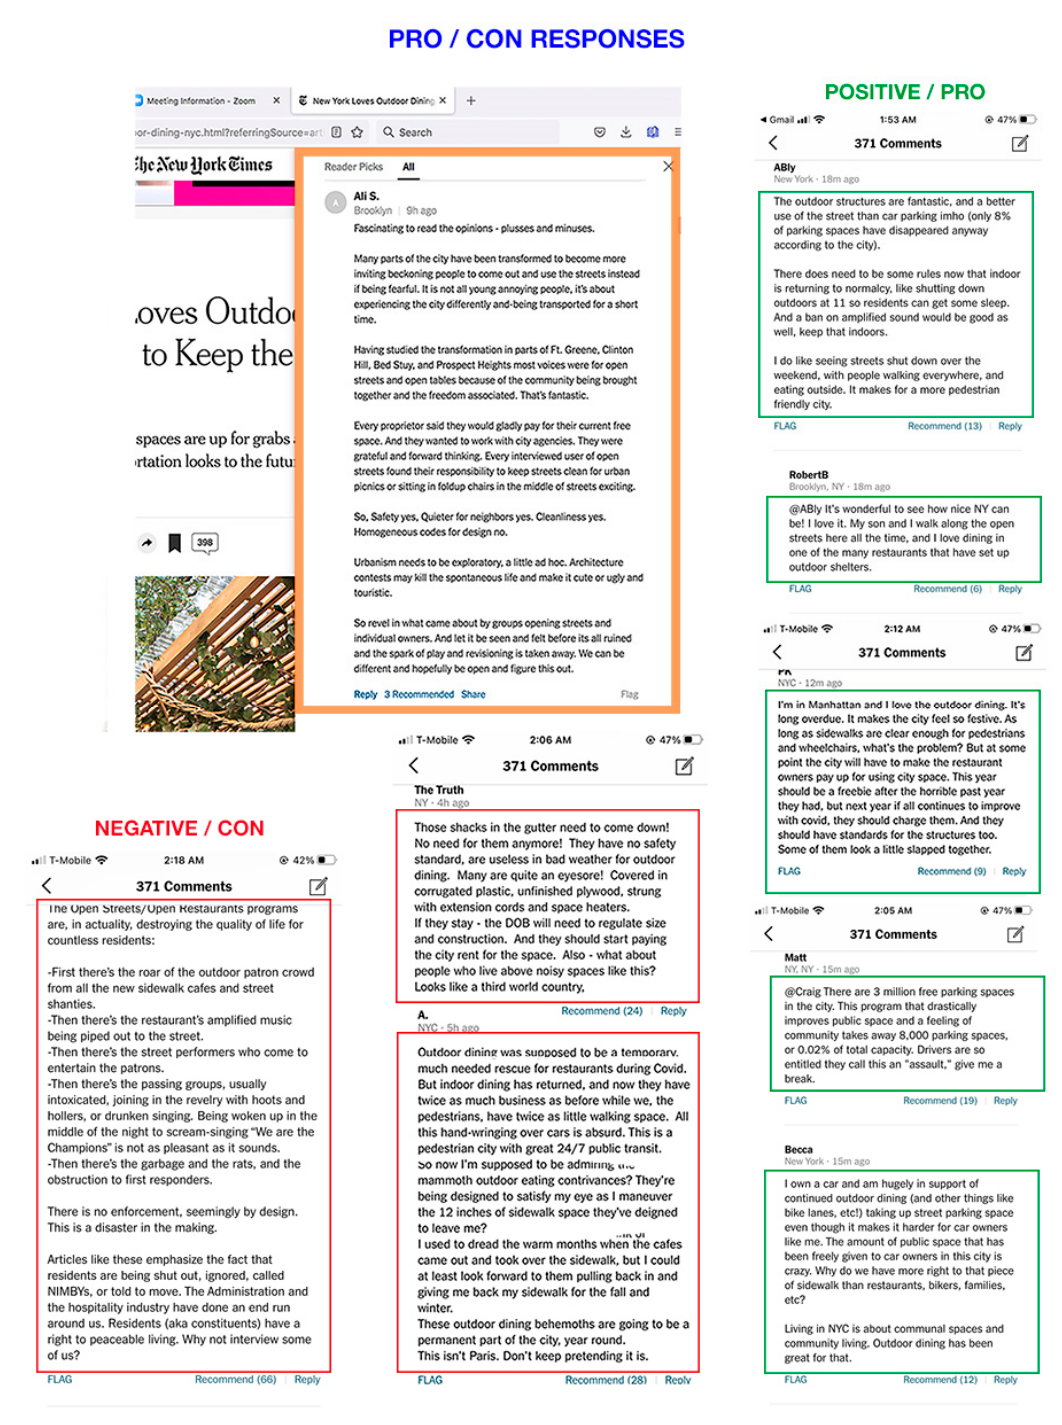
Figure 10. Readers respond to Pete Wells’ New York Times article, including the author (Source: New York Times